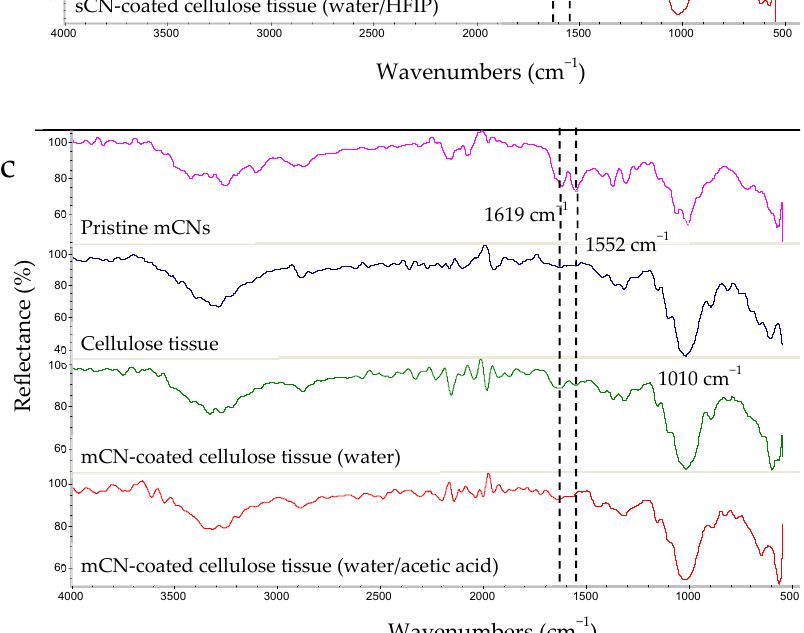
Figure 4. FTIR spectra of: ( a ) dried pristine sCNs and mCNs, ( b ) sCN-coated cellulose tissue using different solvents, and ( c ) mCN-coated cellulose tissue using different solvents.